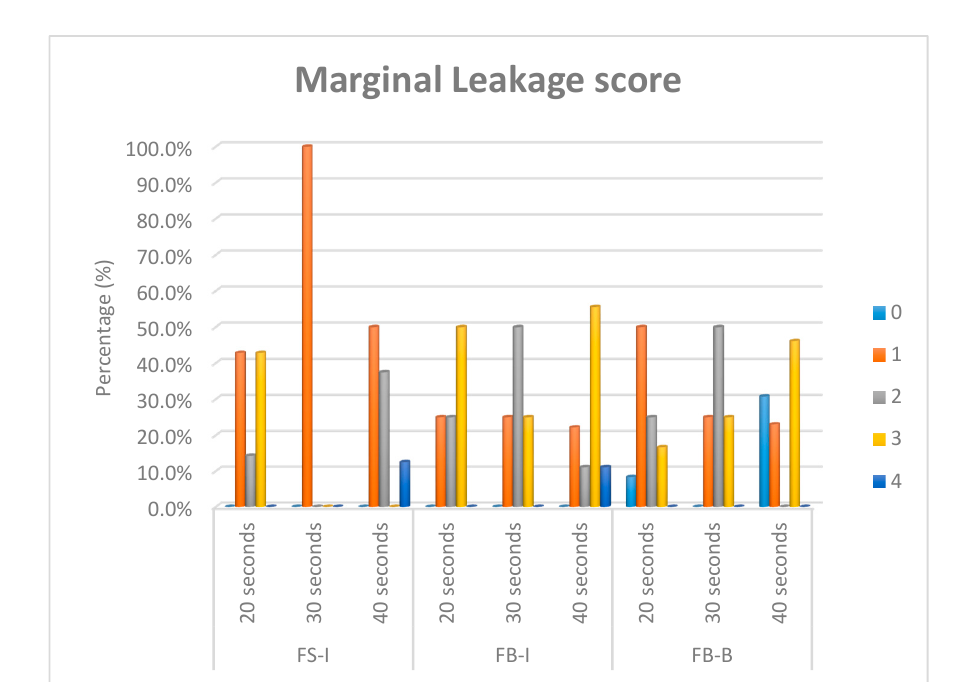
Figure 5. Bar chart showing the percentage (%) of marginal leakage scores for different curing times and packing techniques of Filtek Bulk-bulk (FB-B), Filtek Bulk-incremental (FB-I), and Filtek Supreme-incremental (FS-I).